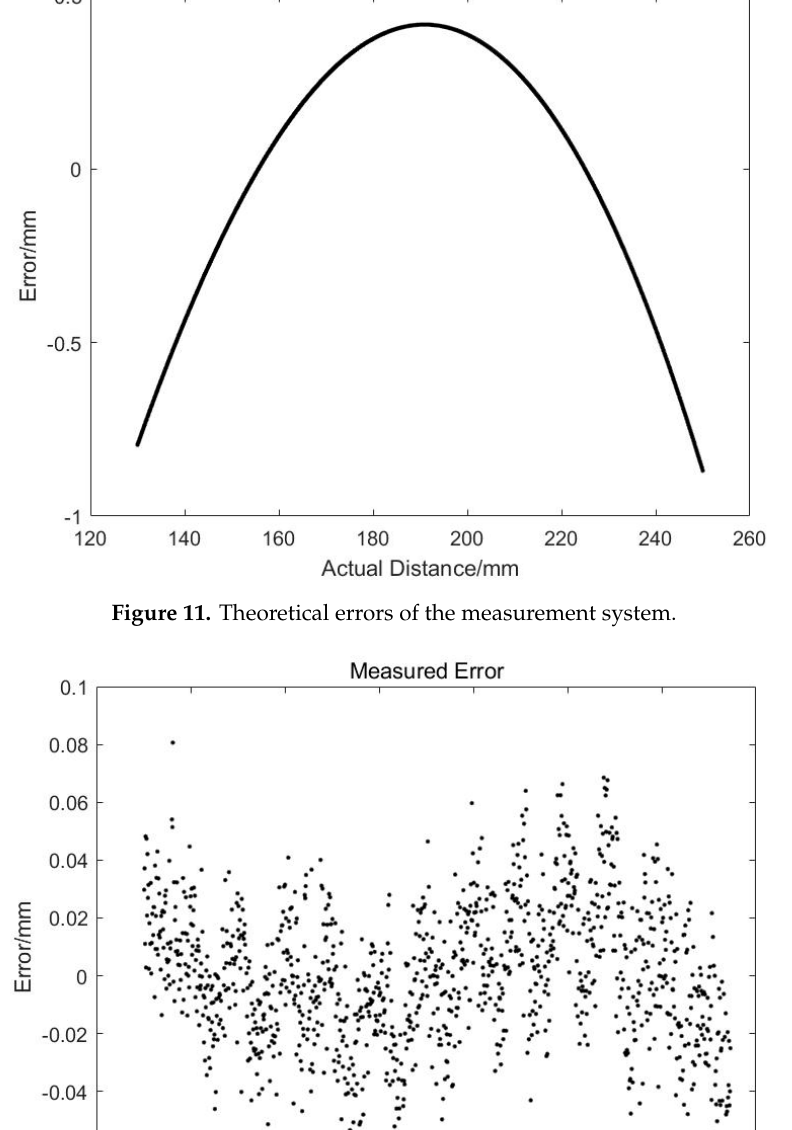
Figure 10. Theoretical linearity of the measurement system.